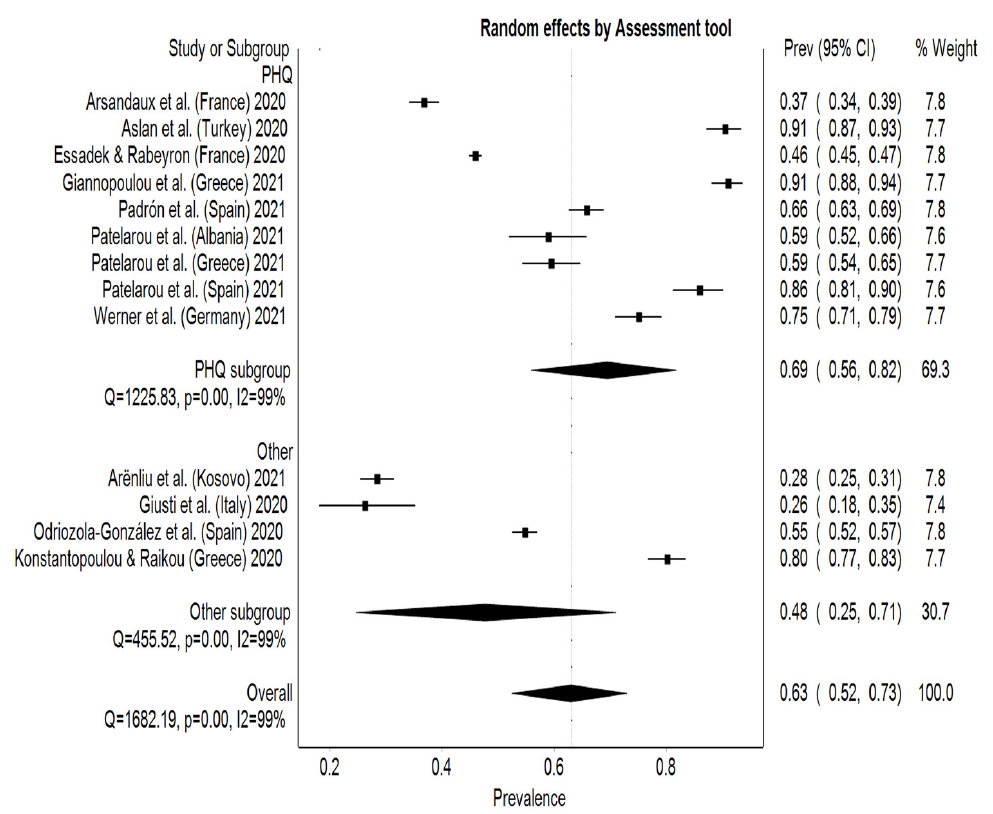
Figure 5. Subgroup analysis between PHQ and other depression questionnaires.